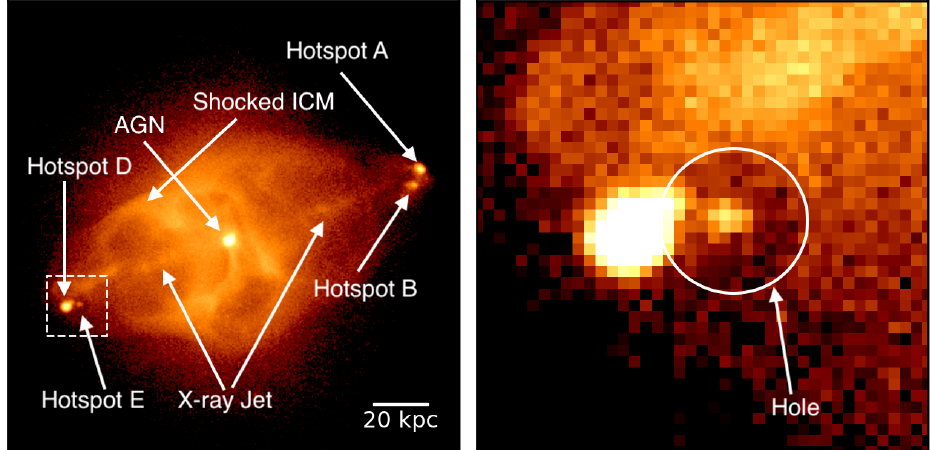
Figure 1. Exposure-corrected Chandra observation of Cygnus A in the 0.5–7 keV band. (Left panel) Entire region containing the shocked ICM, hotspots, X-ray jet, and AGN. (Right panel) Zoom-in (shown in the left panel) of Hotspots D and E, showing in more detail the emission hole surrounding Hotspot E. The contrast in the right panel has been altered for clarity. Reproduced using the same data as